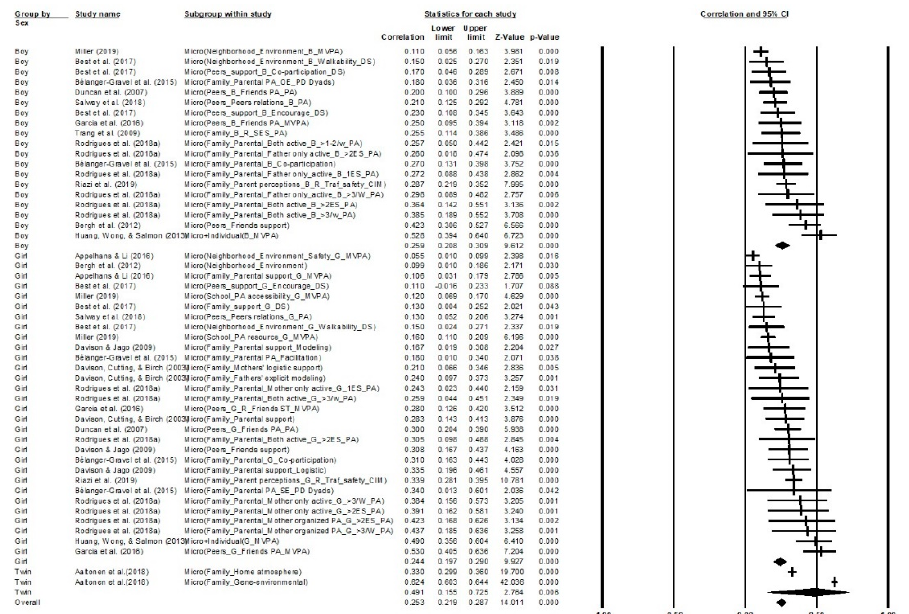
Figure 4. Correlations on individual factors in children and adolescents’ PA. Note. ASP = After school physical activity promotion; ATS = Active transport to school; B = Boy; CIM = Children inde- pendent mobility; DAP = During adolescent period; DS = Daily steps; R = Reversed correlation; EO = Environmental opportunities; ES = Extracurricular sport; G = Girl; OE = Outcome experiences; PD = Parent daughter; SE = Self-efficiency; SPE = School physical education promotion; WD = Weekend; WY = Weekday.